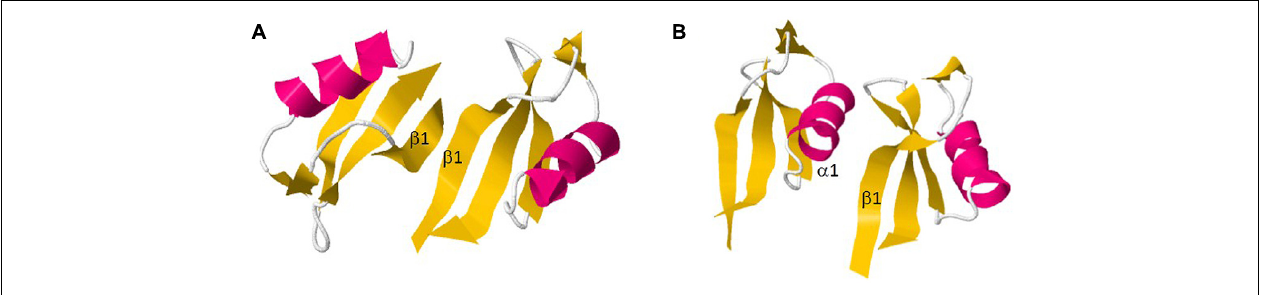
FIGURE 4 | Dimer formation of two plant defensins. (A) NaD1; (B) SPE10. All figures were designed using PyMol Molecular Graphic SystemVersion 1.2r3pre, Schrödinger,